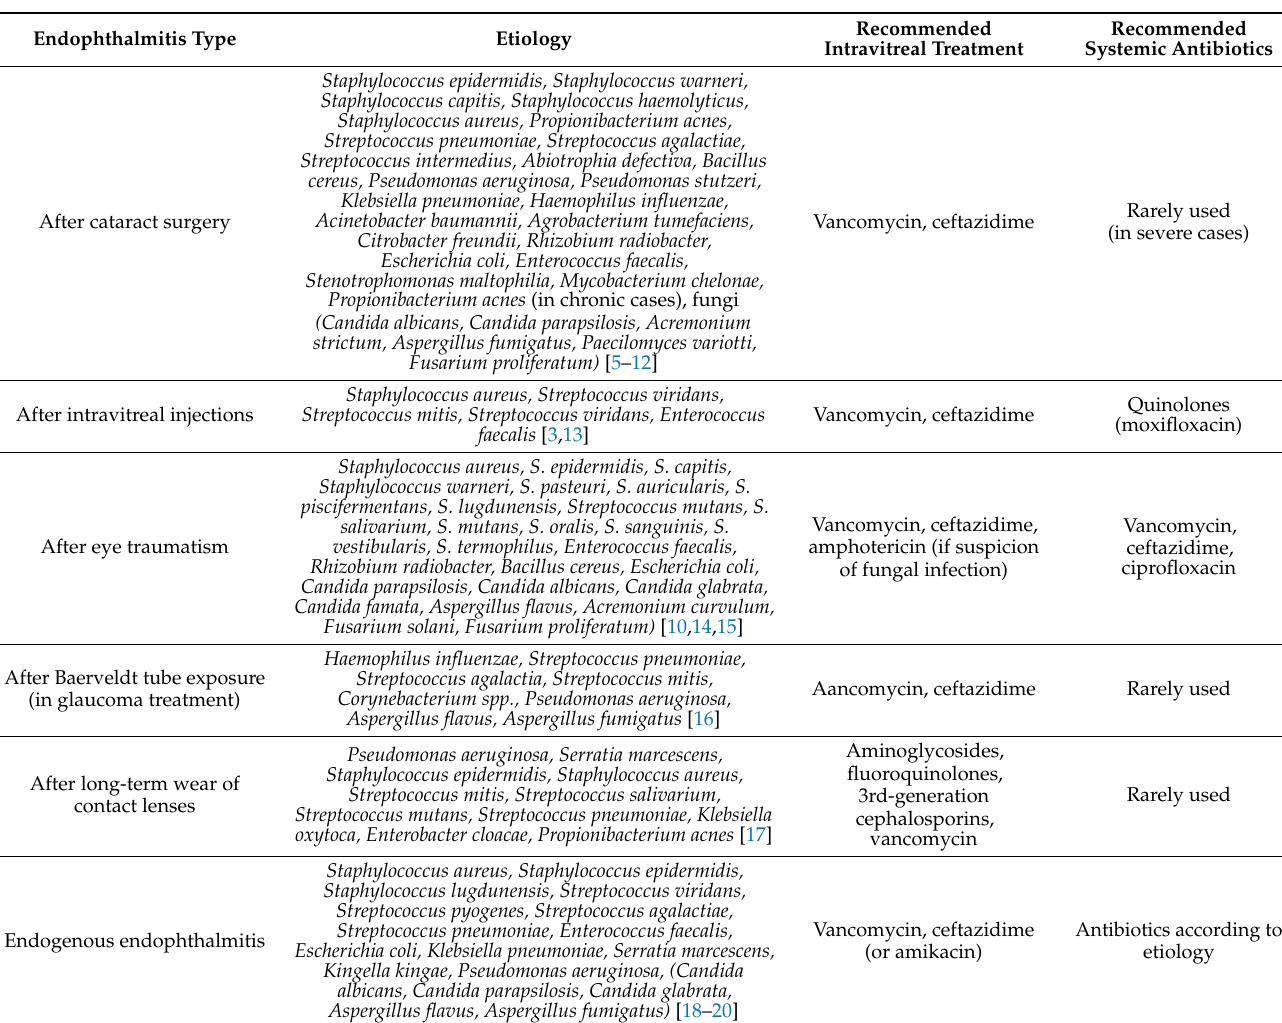
Table 1. Etiology of endophthalmitis by